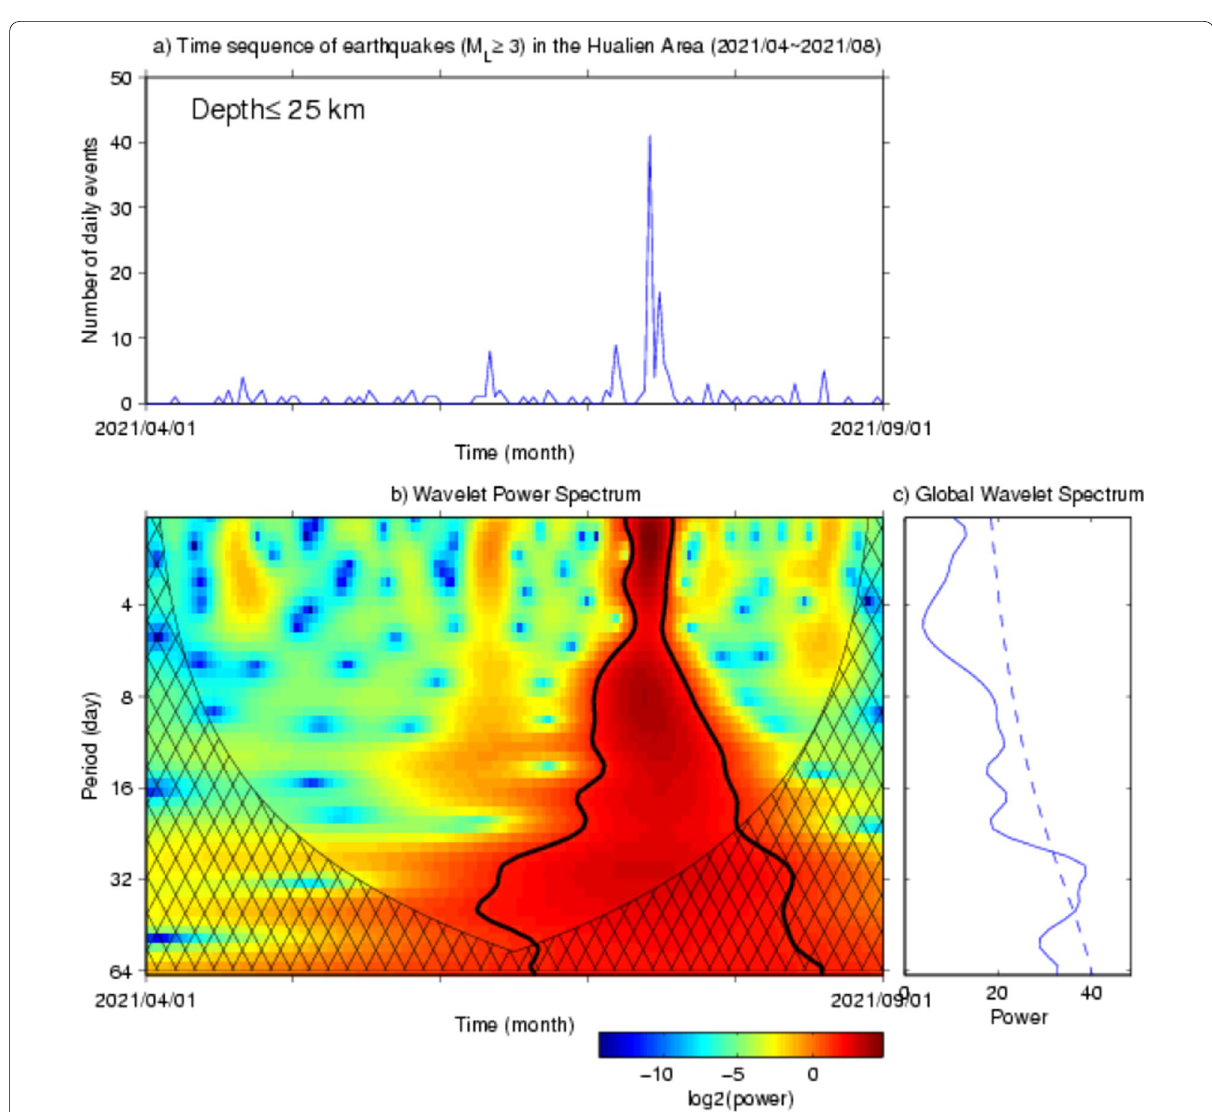
Fig. 5 a for the time sequence of number of daily events with M L 3; b for wavelet power spectrum; and c for the average, or the global wavelet ≥ spectrum, of b over all longitudes. The thick contour is the 95% confidence level, using a white‑noise background spectrum. The black net is described in the text. The dashed line is the 95% confidence level for the global wavelet spectrum, using a white‑noise background